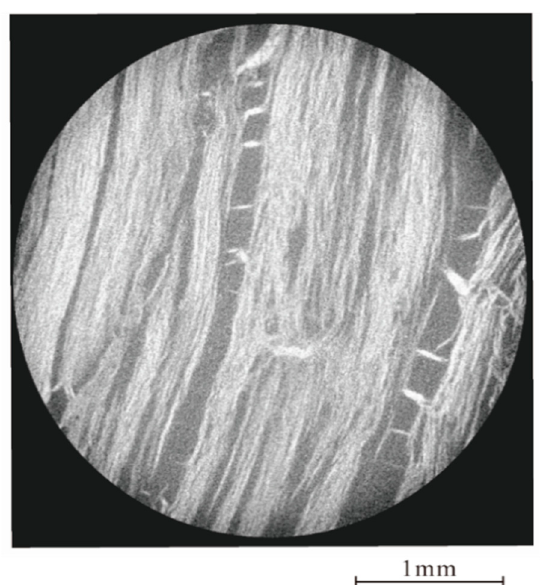
Figure 4. The 2D slice of coal 2–5 without fracture. The coal sample is put into the special core holder, and the holder is fixed on the